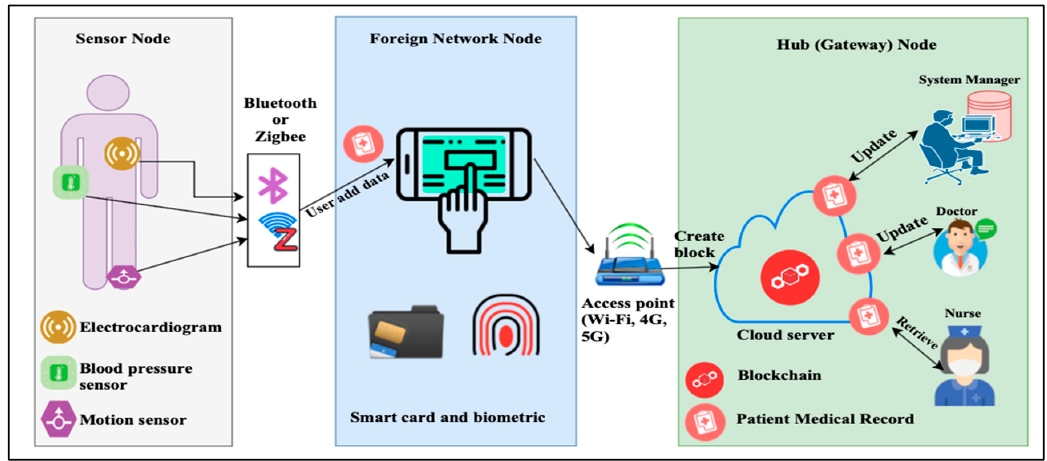
Figure 1. Network model for the Wireless Healthcare Sensor Network (WHSN) system.